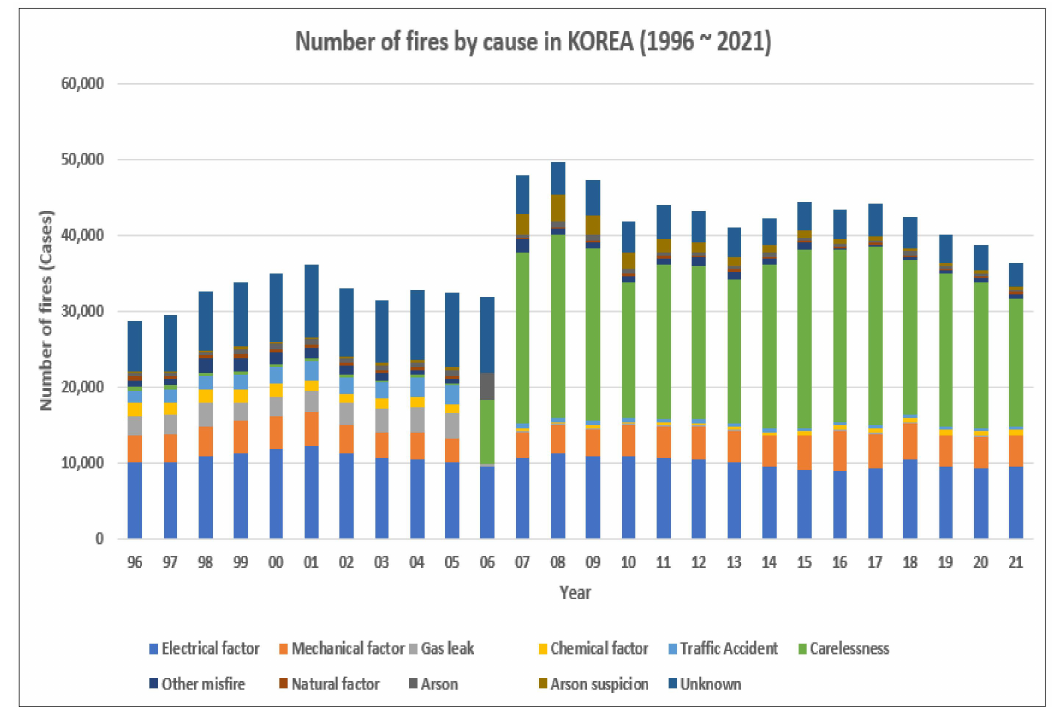
Figure 4. No. of Fires by Cause in ROK